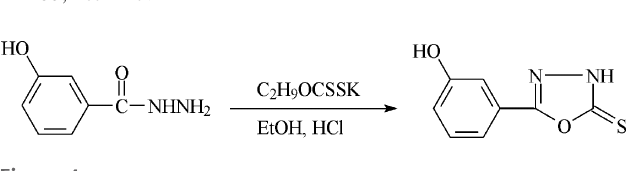
Figure 3 Packing of the molecular entities in the crystal structure, in a view along the b axis. Hydrogen bonds are shown as dashed lines.